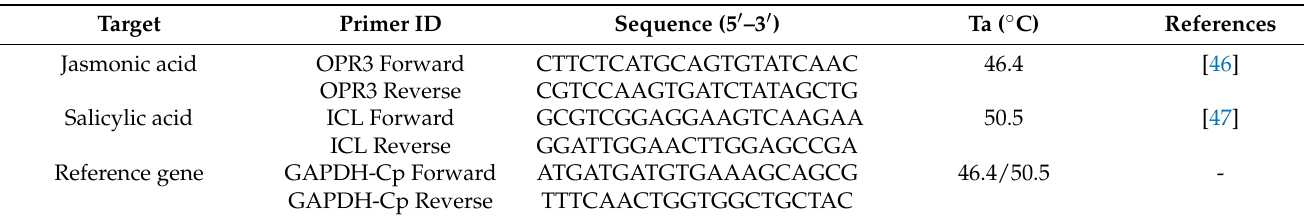
Table 1. Primer and reference genes used in the real-time RT-PCR